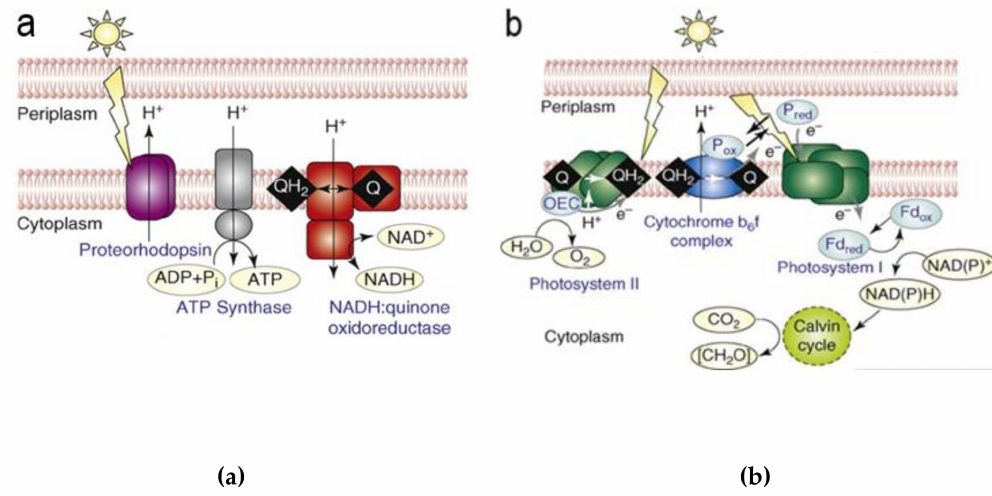
Figure 5. Light-driven biocatalytic processes in vivo. ( a ) ATP synthase and NADH:quinone oxidoreductase catalyze the formation of ATP and NADH using the energy stored in proton gradients generated by proteorhodopsin in bacteria. The reversibility of the NADH:quinone oxidoreductase reaction helps to balance the levels of the reduced and oxidized nicotinamide cofactors and of the redox carriers ubiquinone (Q) and ubiquinol (QH 2 ). ( b ) For oxygenic photosynthesis in cyanobacteria, two photosystems are employed, which transfer electrons (e − ) from water to ferredoxin (Fd). Upon excitation of photosystem II, ubiquinone (Q) is reduced to ubiquinol (QH 2 ). Subsequently, the cytochrome b 6 f complex re-oxidizes QH 2 and reduces plastocyanin (P), which in turn transfers the electrons to the photosystem I. The electron transfer to oxidized ferredoxin (Fd ox ) is then triggered by excitation of photosystem I. The reduction of the nicotinamide cofactors links this process to the carbon fixation in the Calvin cycle. Finally, the oxygen-evolving complex (OEC) oxidizes water to regenerate the system for the next electron transfer. For purposes of clarity, the ATP synthase, which also catalyzes the formation of ATP in this system, has been omitted. Reprinted from E. T. Johnson